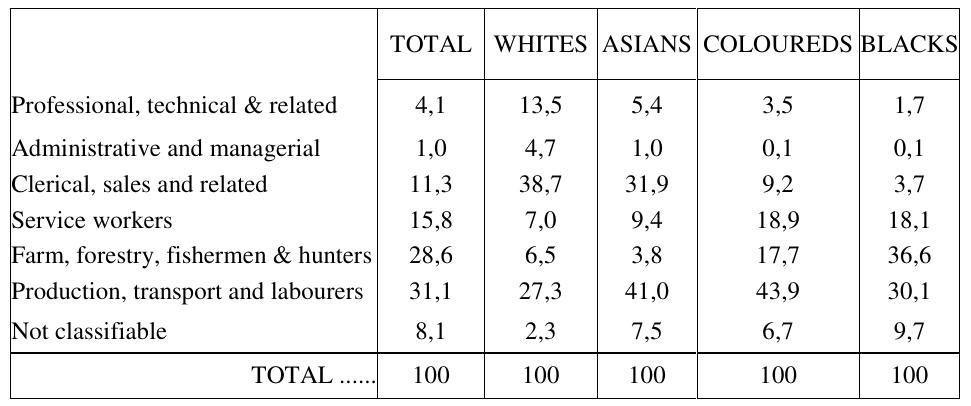
OCCUPATIONAL COMPOSITION OF S.A. POPULATION IN 1970